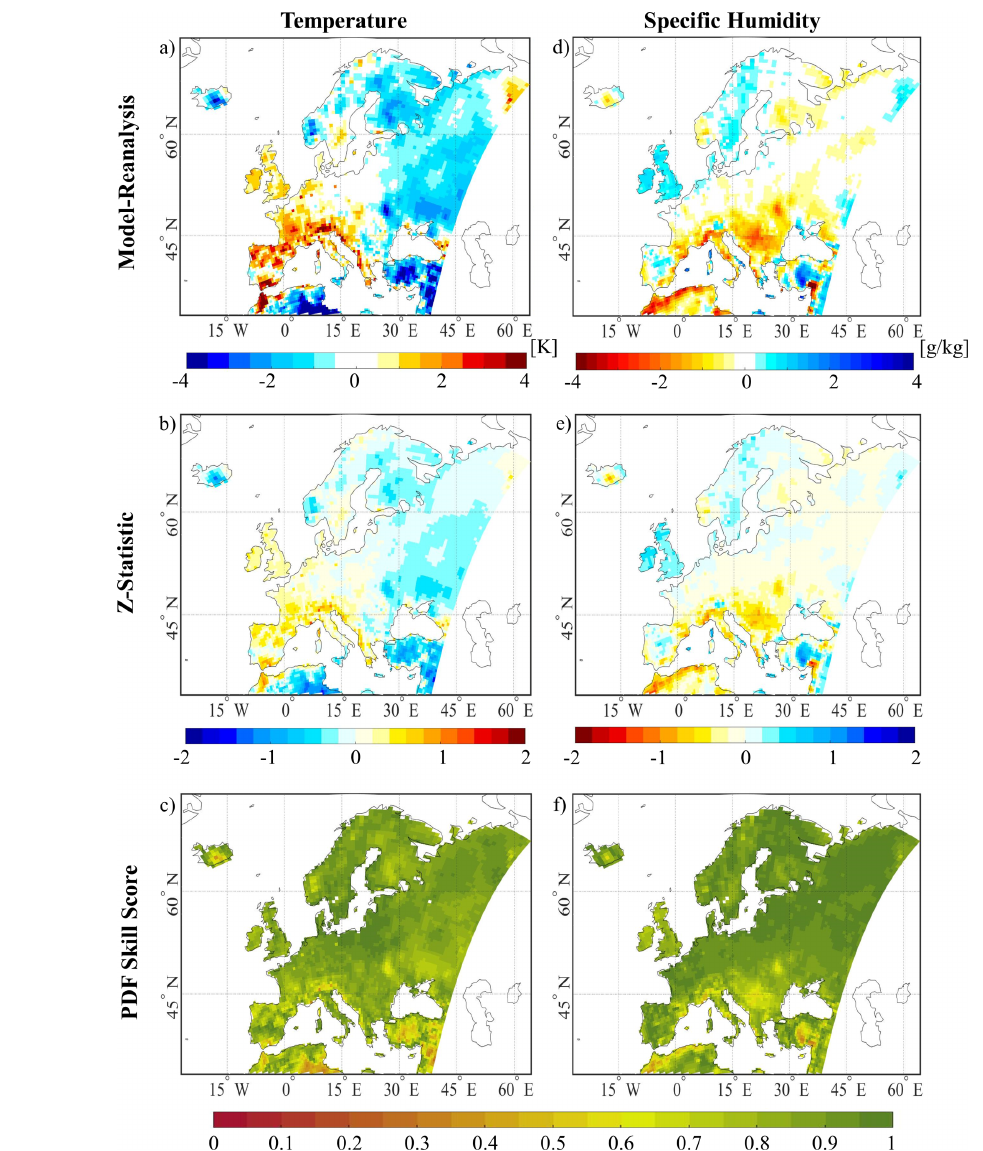
Figure 2. Statistical metrics for comparison of modeled temperature and specific humidity from CTRL with bias-corrected ERA5 reanalysis data (C3S, 2020). Panel (a) shows the value of a Z statistic comparing the temporal distribution of modeled temperature with reanalysis; panel (b) shows the PDF skill score as a second measure to compare the temporal distribution of modeled temperature with reanalysis. Panels (c, d) are the same as (a, b) but for specific